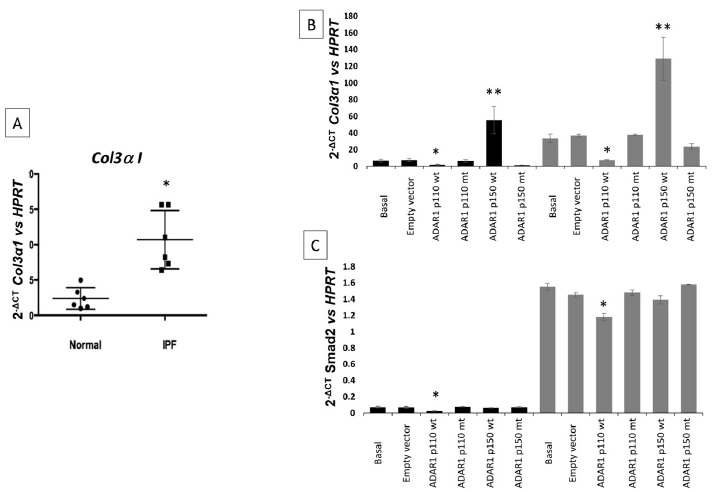
Figure 7. Over-expression of COL3A1 in IPF fibroblasts (black square) vs Normal fibroblasts (black circle) (* p < 0.05) ( A ), Over-expression of ADAR1p110 wt isoform showed a negative effect on